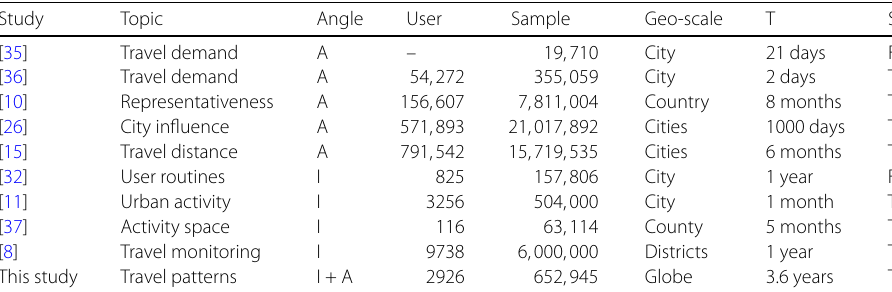
Table 1 Representative studies of travel behaviour using social media data. T is the time span covered by the dataset. S represents data source. On the Angle column, A indicates aggregate/lateral level and I indicates individual/longitudinal level. On the S column, F indicates Foursquare and T indicates